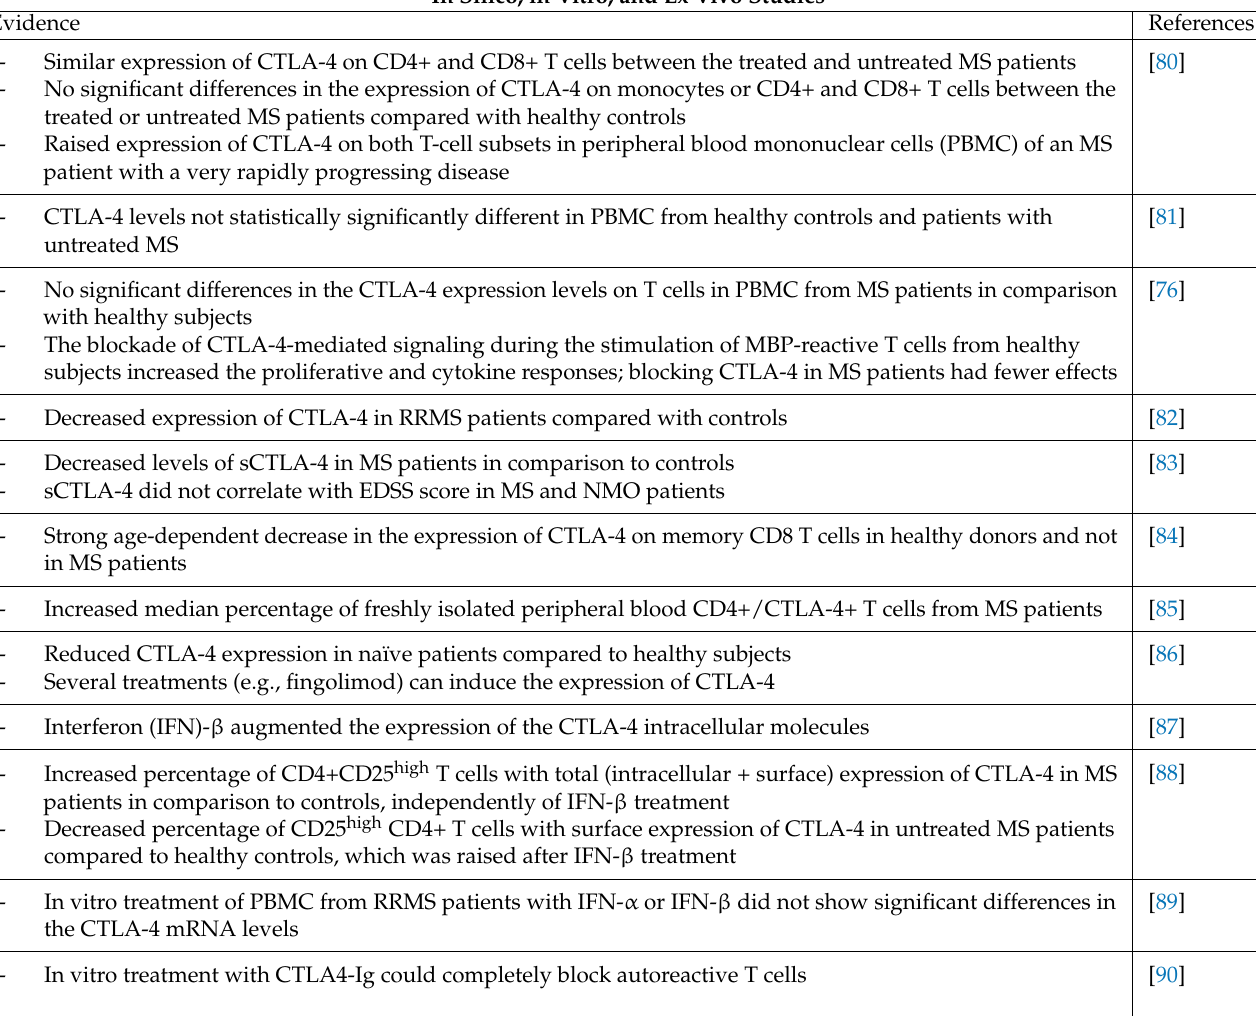
Table 1. Schematic overview of the most important evidence from the in silico, in vitro, and ex vivo studies investigating the role of CTLA-4 in